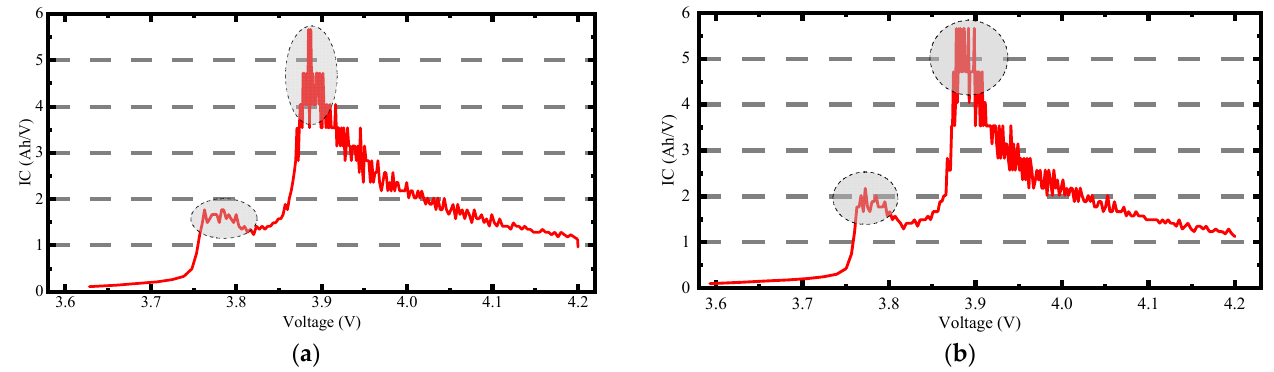
Figure 2. IC curve of battery CS2–35 and CS2–36 at the 50th cycle. ( a ): IC curve of the 50th cycle of CS2–35 battery. ( b ): IC curve of the 50th cycle of CS2–36 battery.